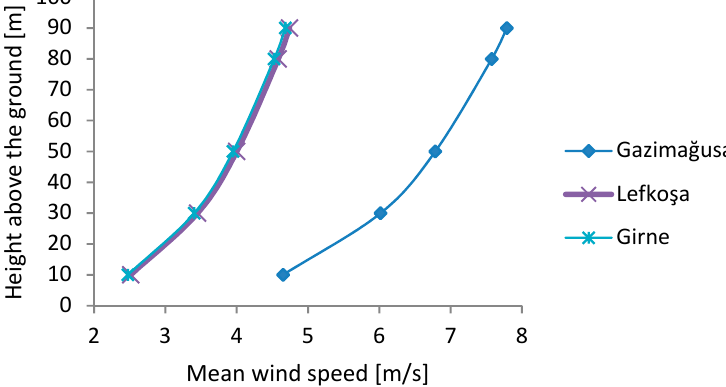
Figure 8. Vertical wind shear profile at six studied locations. Table 6. The annual wind power density at various heights.